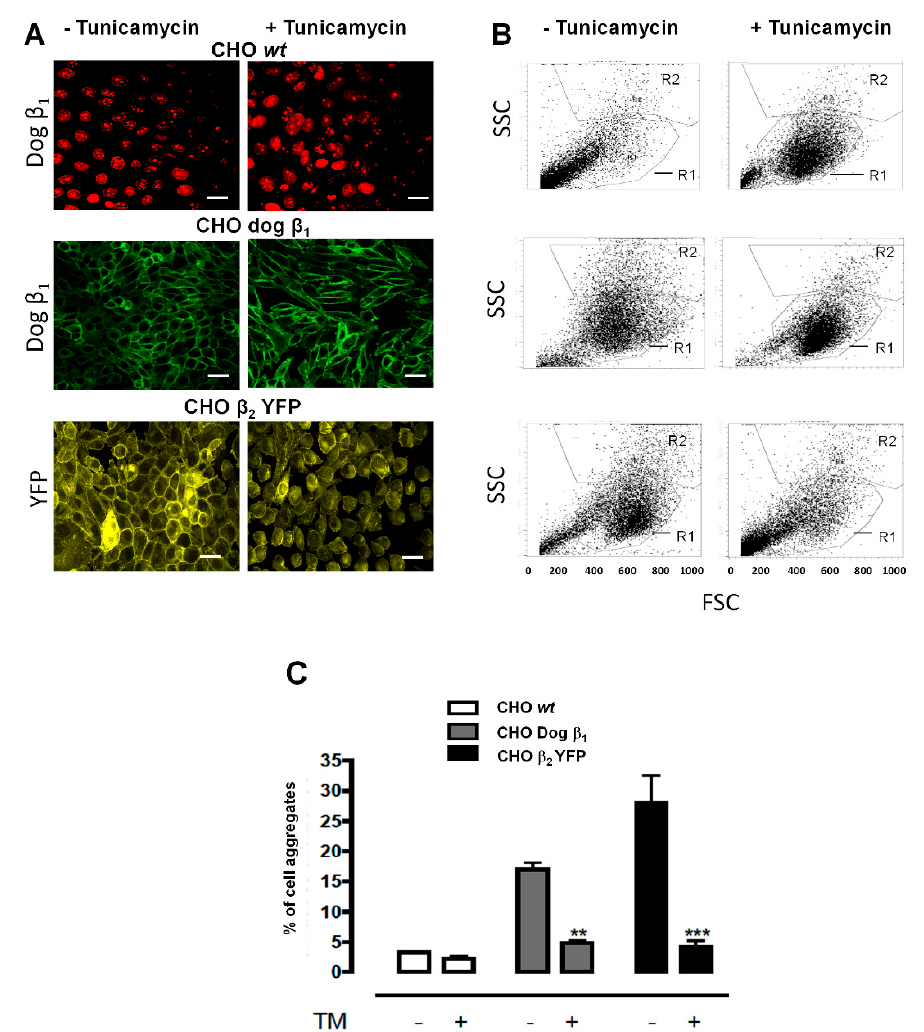
Figure 4. Cell aggregation of CHO cells expressing β 2 YFP depends on the presence of N-glycan. ( A ) The indicated CHO cells were cultured in the absence and presence of Tunicamycin as described in Methods. A confocal image of each cell type during culture is shown. CHO wt cells (Upper panels) and expressing dog β 1 subunit (Middle panel) are treated for immunofluorescence with anti- β 1 antibody. CHO β 2 YFP cells (Lower panel) are imaged for YFP auto-fluorescence. ( B ) The percentage of cell aggregates formed was calculated by flow cytometry. A representative dot plot of Forward Scatter (FSC) versus Side Scatter (SSC) is presented for each cell type. The percent of events in R2 represents the percent of cell aggregates. ( C ) The percent of cell aggregates in R2 were averaged and illustrated in a comparative bar graph. The amount of cell aggregates of fully glycosylated CHO dog β 1 and CHO β 2 YFP cells is significantly higher than that of CHO wt cells. Error bars, ± S.D. ( n = 5); **, significant difference from CHO dog β 1 , p < 0.005, ***, significant difference from CHO β 2 YFP, p <